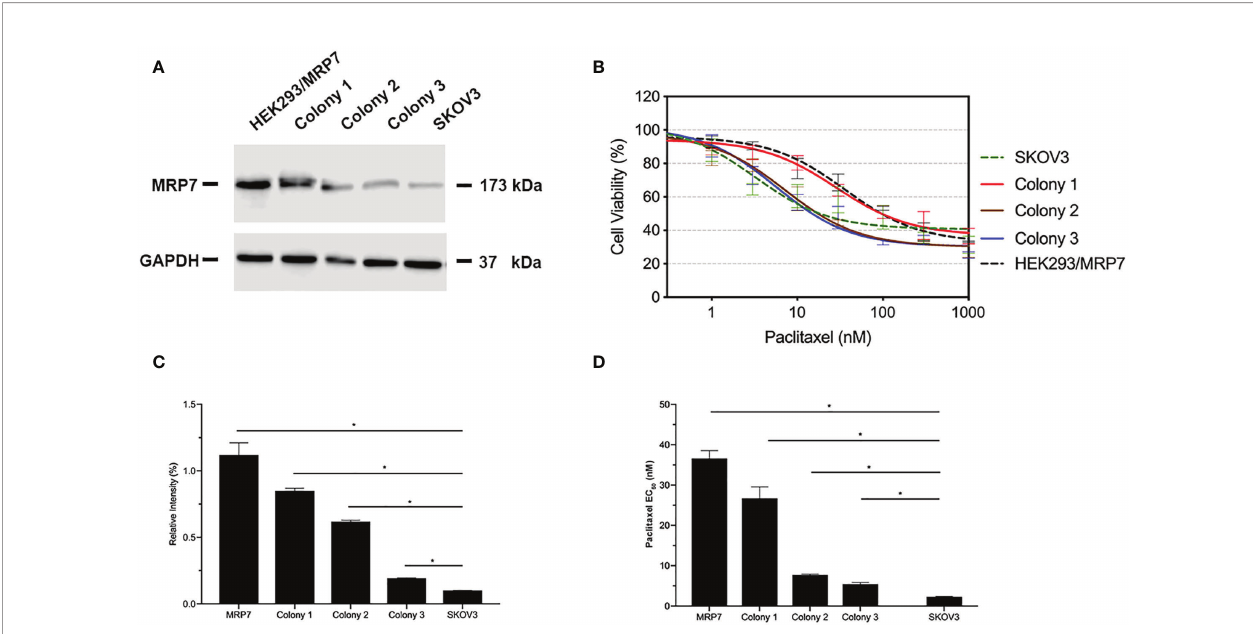
FIGURE 1 | MRP7 expression and paclitaxel cytotoxicity in SKOV3/MRP7 cells. HEK293/MRP7 and SKOV3 were used as positive and negative controls respectively. (A) Western blotting results showing MRP7 expression of selected colonies and controls. (B) Cytotoxicity of paclitaxel in selected colonies and controls. (C) Semi- quantitative analysis of MRP7 protein expression showed in (A) . (D) Paclitaxel EC 50 in selected colonies and controls. In (C) and (D) . “ MRP7 ” stands for “ SKOV3/MRP7 ” . *p < 0.05 versus the negative control